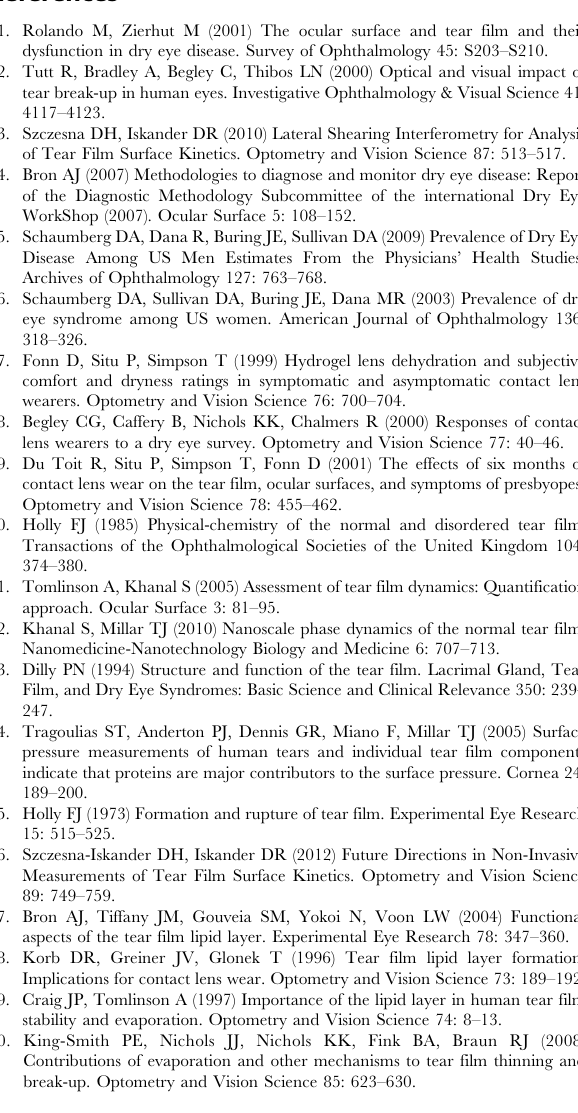
B’ and ‘tail A’, correspondingly) of POPE and POPC lipids are depicted. (TIFF) Figure S2 Density profiles of non-polar lipids at APPL= 68 A˚ 2 . The data are averaged over the simulation time from 0.2 m s to 1.2 m s. Density profiles of both glycerine backbone and tails are shown for TG. In the case of CE, profiles of both ring system and tail are depicted.